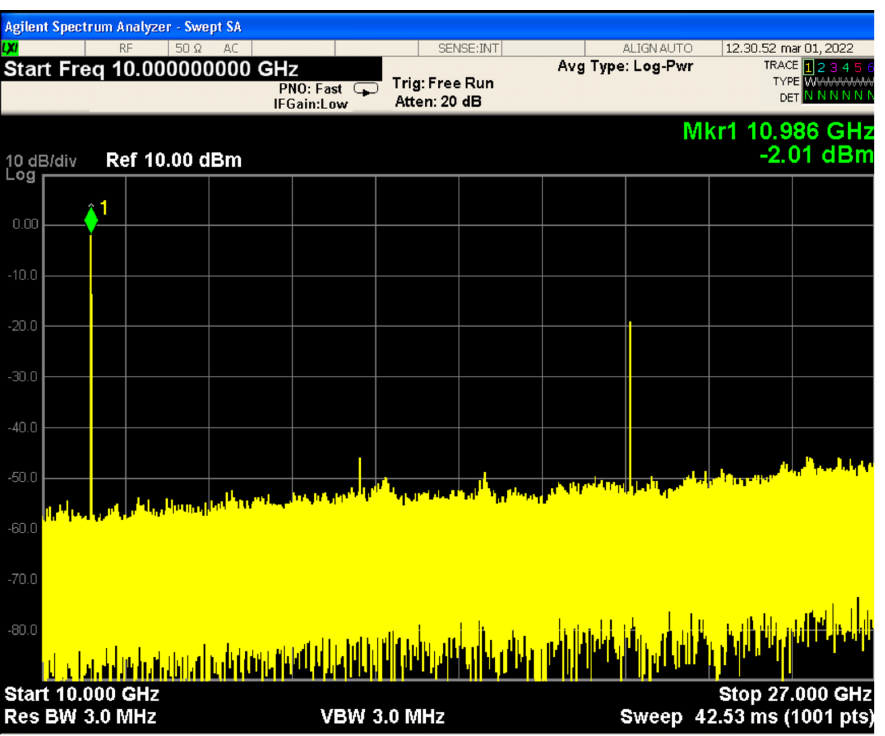
Figure 2. Frequency spectrum at the output of the frequency doubler MMD 1030HS. The input sig ‐ nal was centered at 5.5